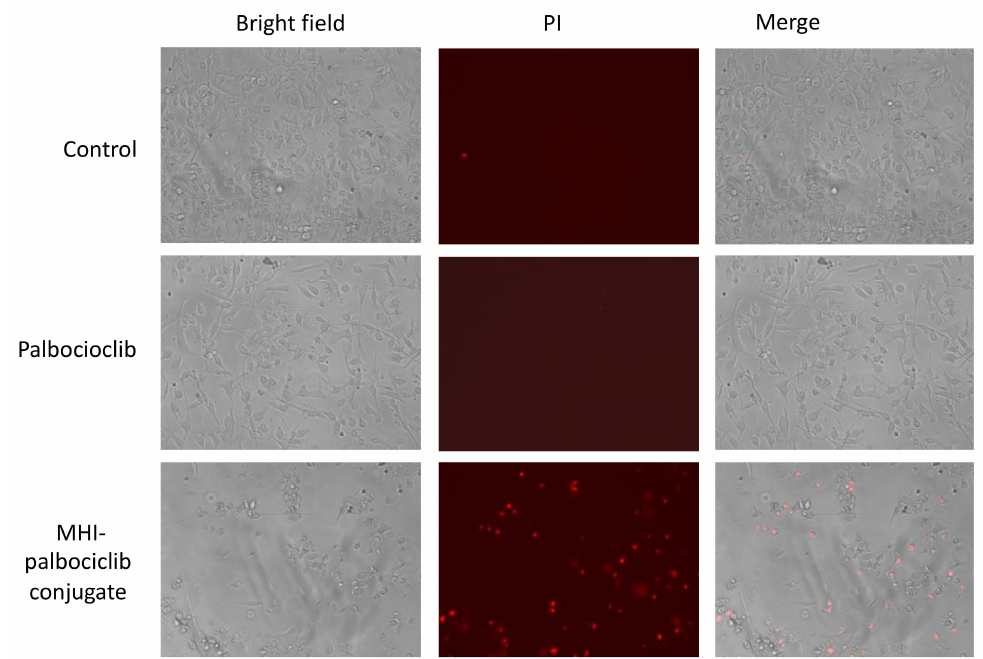
Figure 5. Cytotoxicity in MDA-MB-231 cells after MHI-palbociclib treatment is significantly greater than after treatment with palbociclib. After exposure to 1 µ M of indicated compound for 24 h, dying cells were stained by propidium iodide (red). Photographs were taken by a Floid imaging station (460 × magnification). Representative images of three independent experiments are